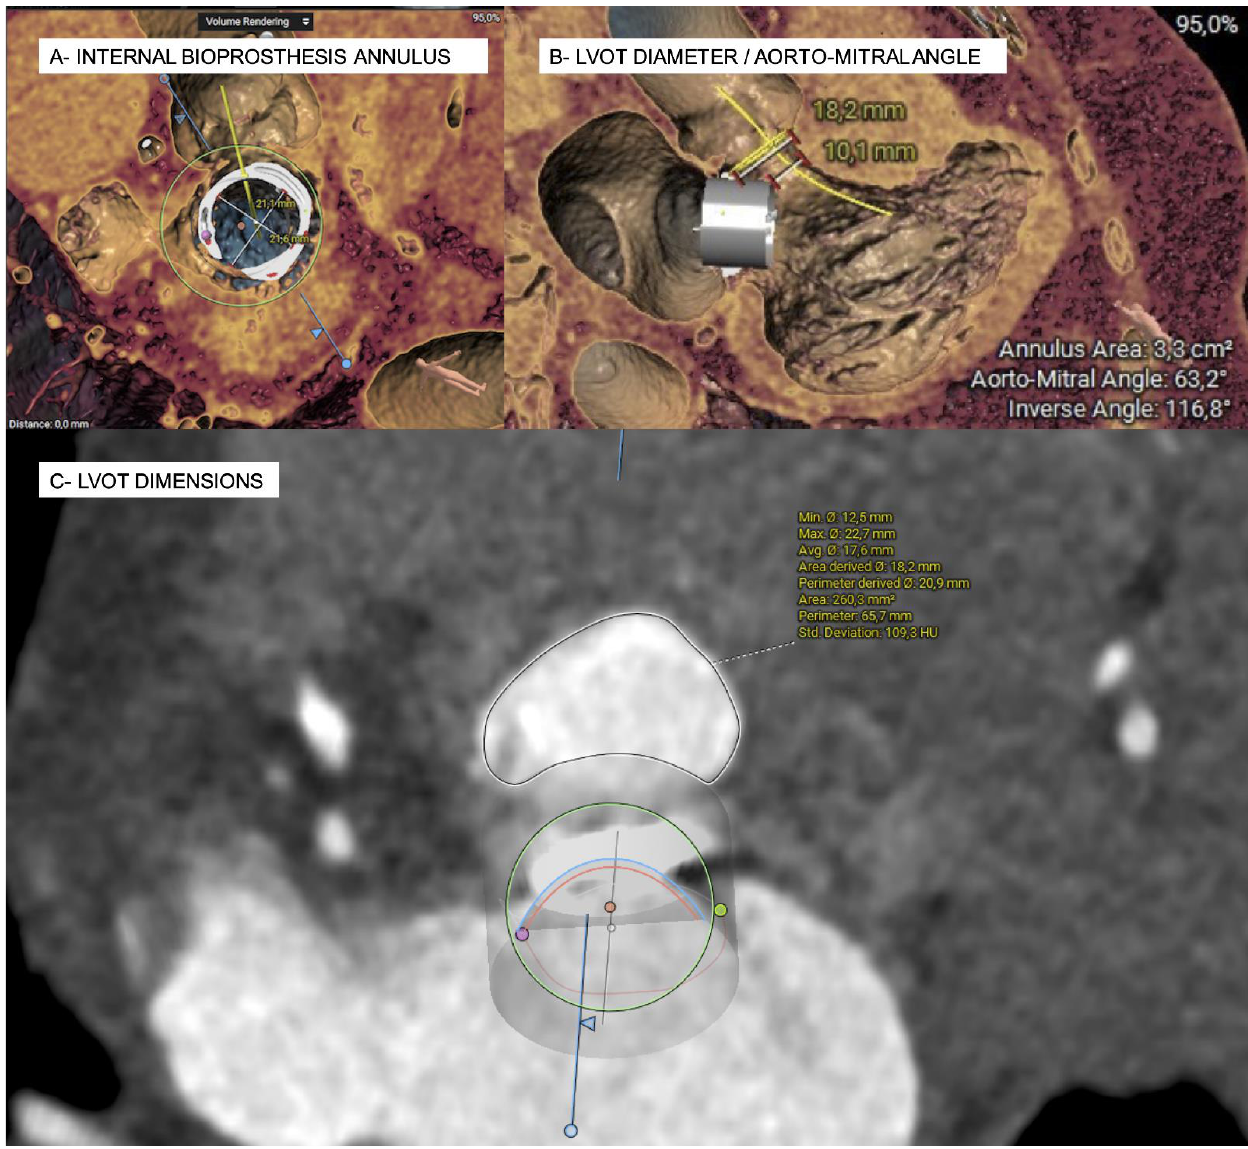
Figure 2. Simulation of a mitral valve-in-valve implantation and estimation of the neo-LVOT surface area on MSCT in systole using the 3 Mensio structural heart module software (Pie Medical imaging, Bilthoven, The Netherlands).